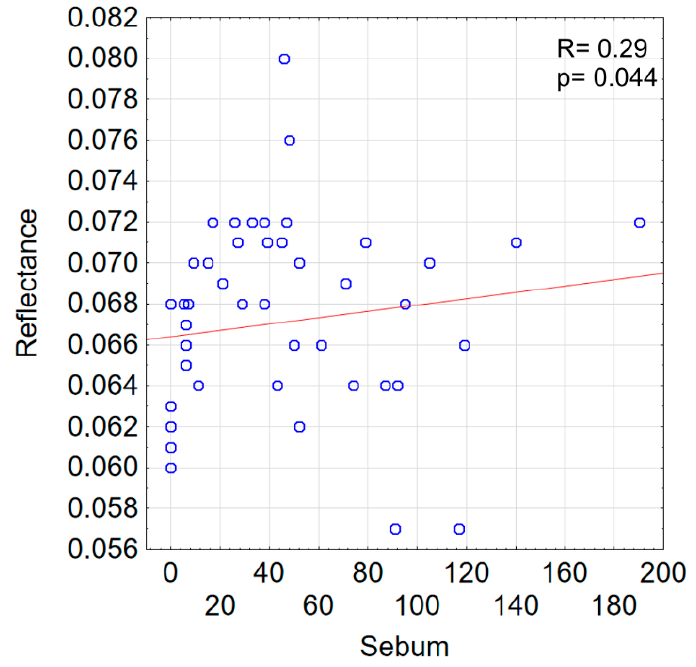
Figure 9. Correlation of sebum and skin reflectance at the wavelength 1700–2500 nm. Red line—trend line.